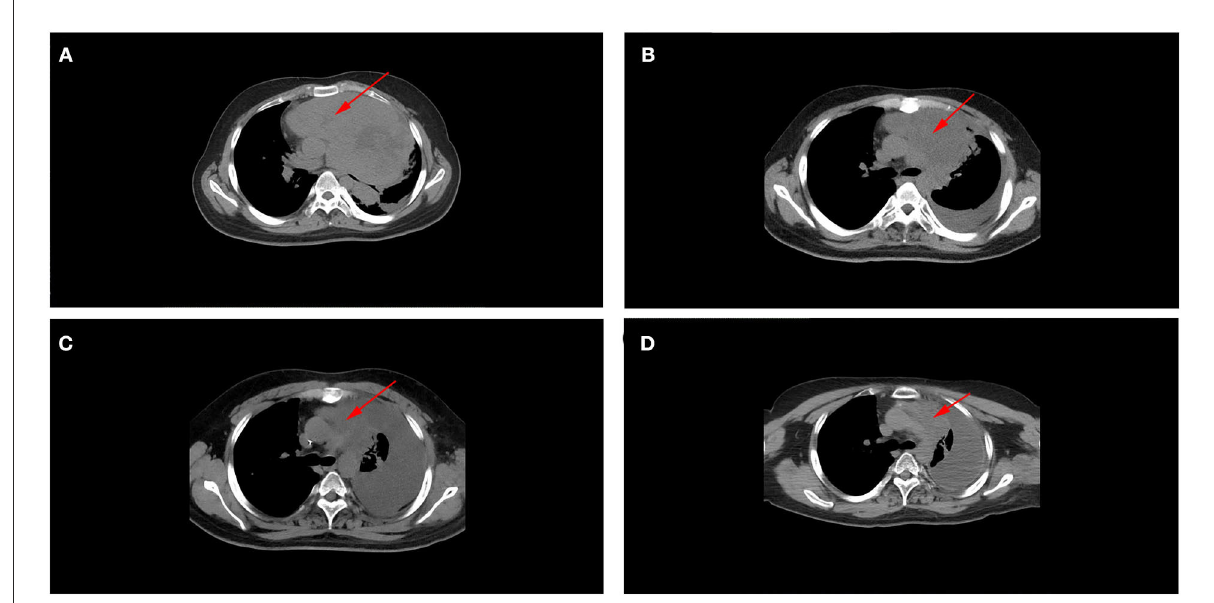
FIGURE3 (A) Chest CT scan (before treatment, after radiotherapy, after chemotherapy, and at a recent point), showed a large space-occupying lesion with bronchial occlusion in the left thoracic cavity with an unclear mediastinum boundary. (B) As treatment continued, the lesions gradually shrank, and left pleural effusion increased. (C,D) No significant change was observed in lung metastases between the end of chemotherapy and the last follow-up period, and they were similar in size (these red arrows indicate lung